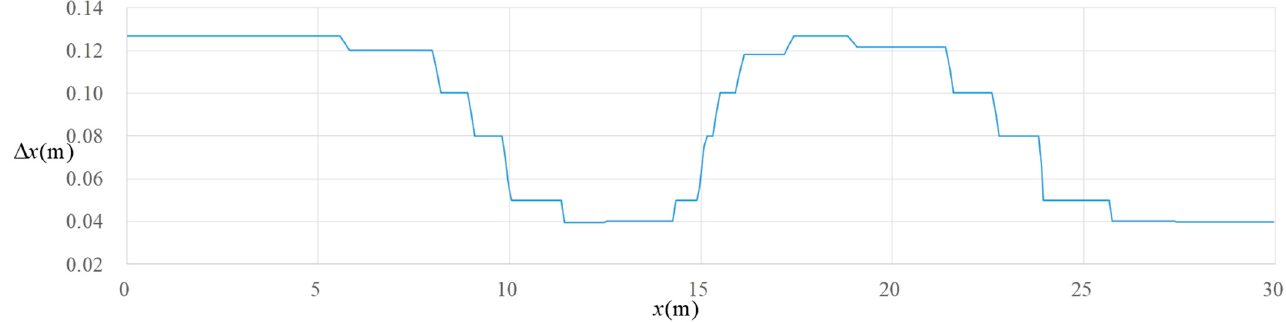
Figure 8. The nodal spacing for the simulation of the nonlinear modulation of periodic waves passing over a submerged obstacle.